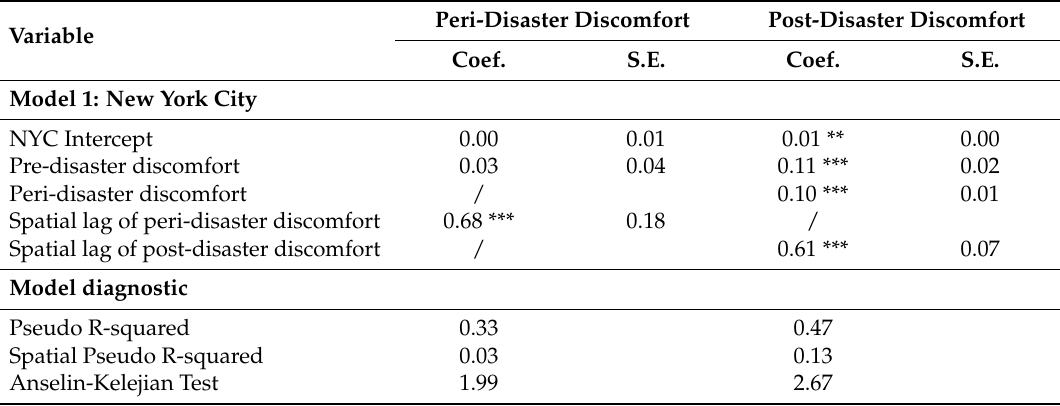
Table 2. Spatial regression results. Model 1 is a spatial lag regression model. Peri-Disaster Discomfort Post-Disaster